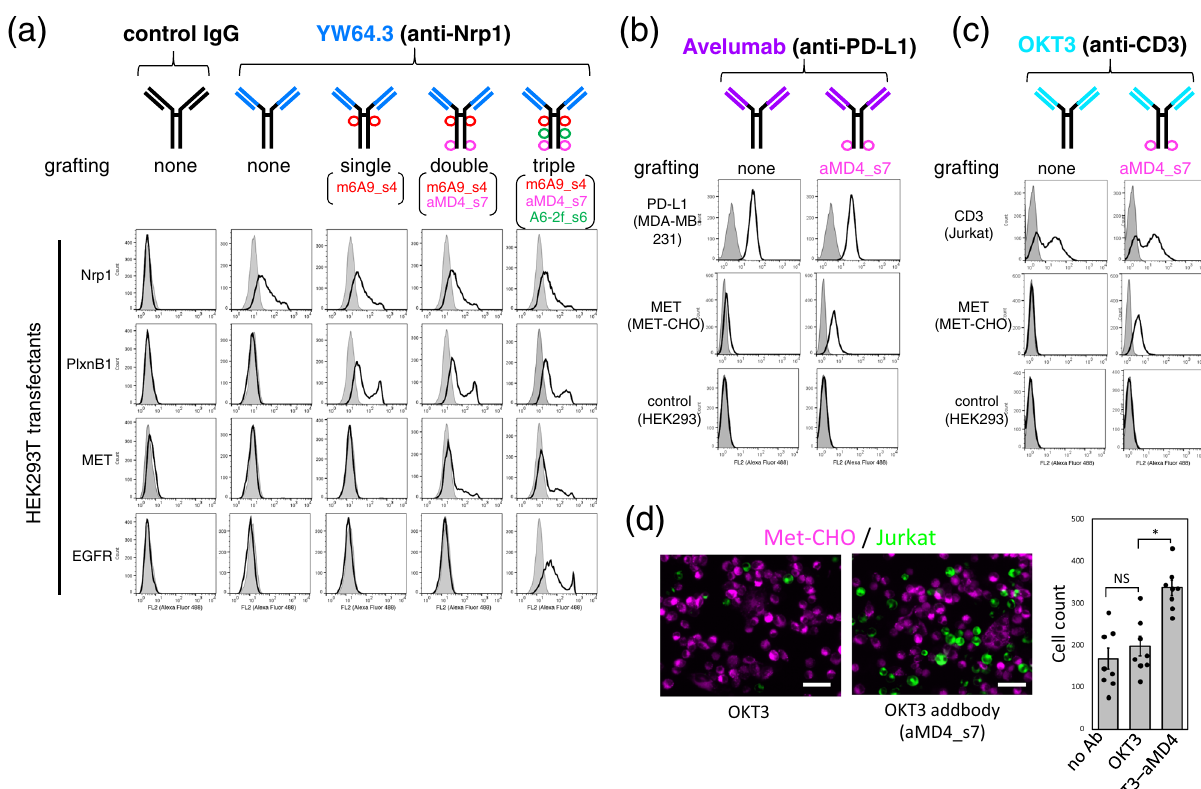
Fig. 5 Instant formulation of multi-speci fi c antibodies by peptide grafting onto IgG, addbodies. a – c Flow cytometric analysis of grafted antibody binding to cells expressing antigens (indicated on the left). Antibody scaffolds include anti-neuropilin-1 YW64.3 ( a ), anti-PD-L1 avelumab ( b ), and anti-CD3 OKT3 ( c ). Each antibody design is depicted schematically above the panels. The gray histograms in a represent binding to untransfected HEK293T cells, while those in b and c are for the labeling of the same cells with the IgG control. d Addbody-mediated heterotypic cell engagement. DiI-labeled MET-CHO cells (magenta) adhered onto the plate were overlaid with DiO-labeled Jurkat cells (green) and incubated with OKT3 (left) or the OKT3-aMD4 addbody (right) for 30 min. After washing, the remaining cells were photographed (bar, 100 µ m). The number of attached Jurkat cells was counted for multiple fi elds ( n = 8) and shown in the right as mean ± SD (* p = 0.0021, two-sided t -test; NS not signi fi cant). Source data are provided as a Source Data fi le. NATURE COMMUNICATIONS| (2021) 12:1543